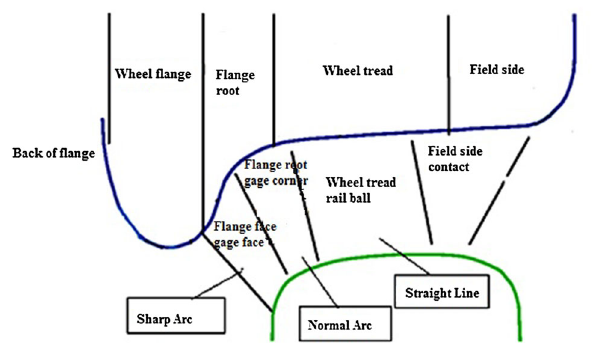
Fig. 1 Contact points of the rail and wheel in a variety of paths [23]